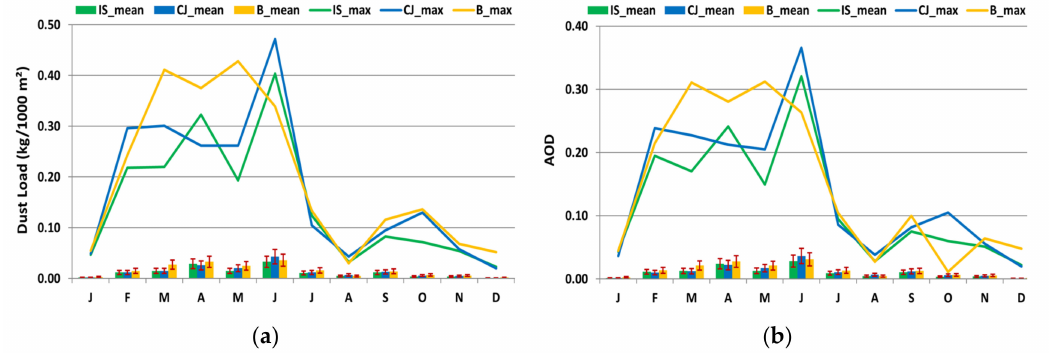
Figure 6. The distribution of the multi-monthly mean (columns) and absolute maximum (lines) for DL ( a ) and AOD ( b ) between December 2015–February 2019 over Ias Bucharest